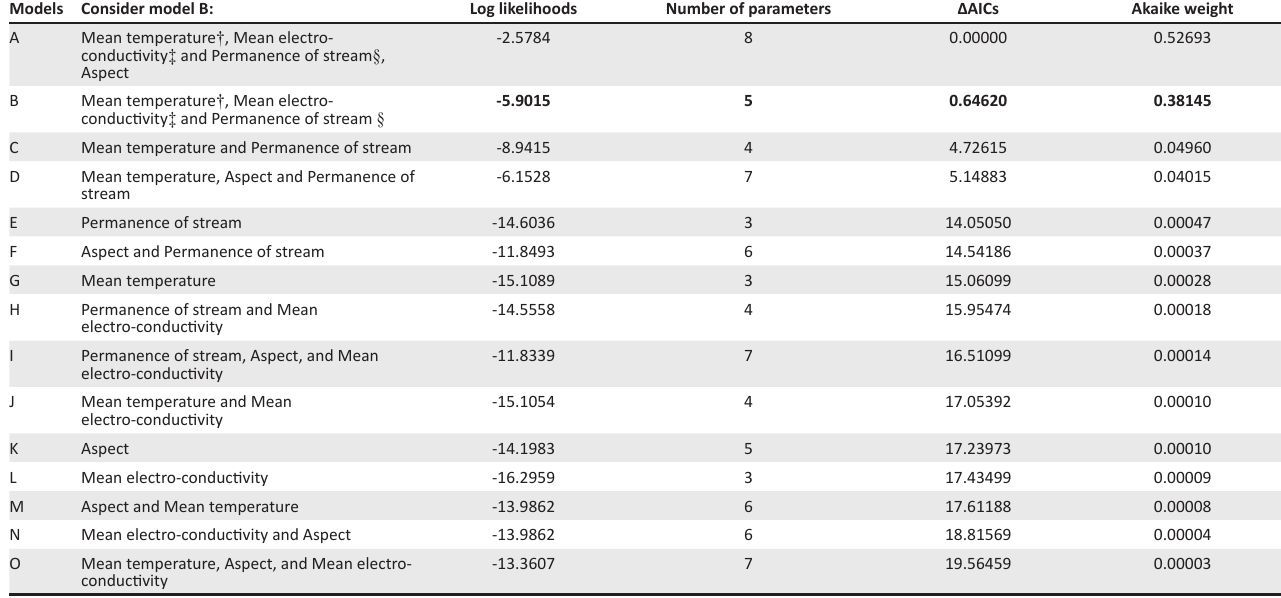
TABLE 1: Four variables were considered for Linear Models. Models Consider model B: